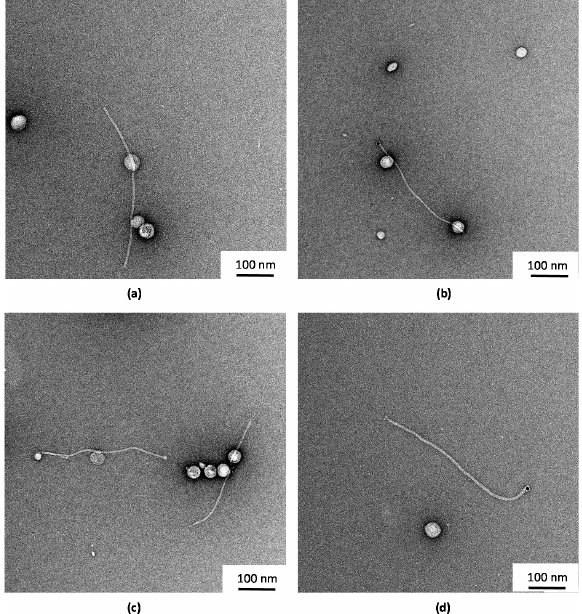
Figure 4. TEM images of single phages with bonded Au NPs in numbers of 2–3 in the centrum ( a ), of 2–3 in the head and tail ( b ), with 4 or more aggregated nanoparticles ( c ) and with low number of NPs of different size in micrometric phage filamentation ( d